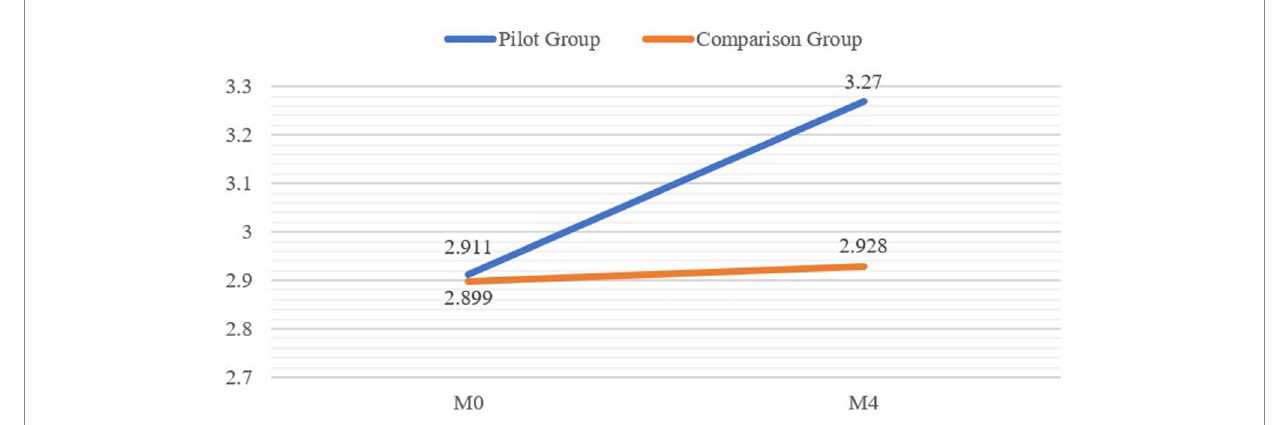
FIGURE 2 Group comparison of career and life development hope from